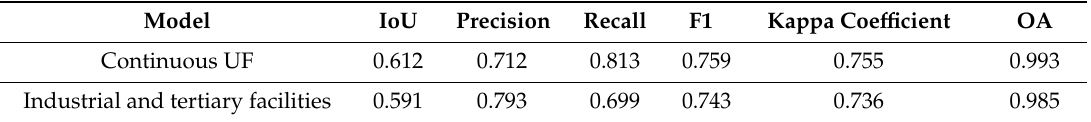
Table 10. Evaluation metrics of the multi-temporal model computed over the validation set for two classes: continuous habitat and industrial facilities.